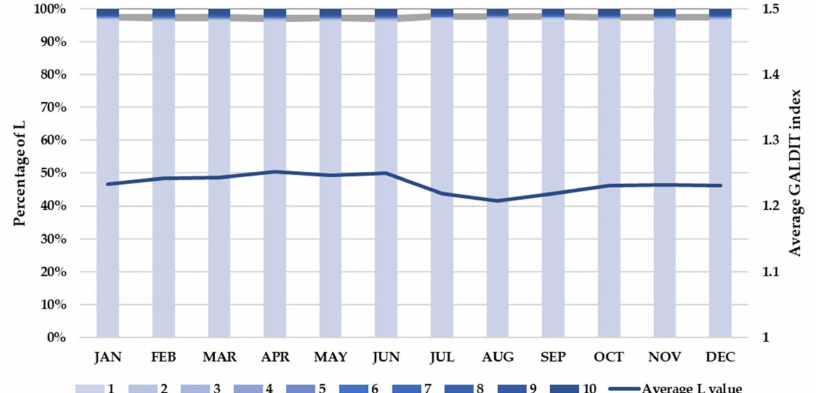
Figure 7. Distribution of the dynamic parameter’s rating for 10-year-averaged monthly height of groundwater level above sea level